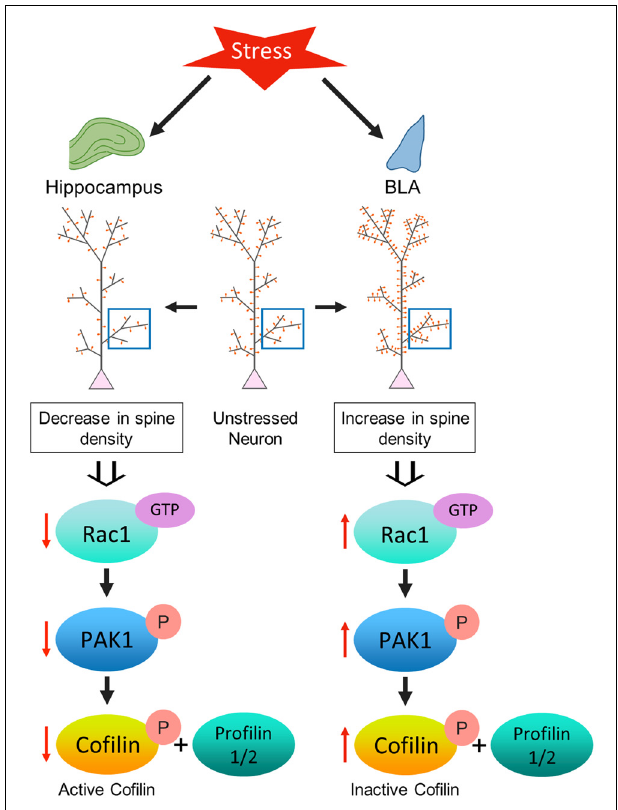
FIGURE 5 | Model depicting the proposed mechanism underlying the contrasting effect of stress-induced structural plasticity in the hippocampus and amygdala. (Left) Schematic representation of the effect of stress on the hippocampus. Chronic stress leads to an aberrant decrease in Rac1 activity in the hippocampus which in turn leads to a decrease in PAK1 phosphorylation. A decrease in PAK1 activity ultimately brings about a decrease in cofilin phosphorylation. An increase in cofilin activity along with a simultaneous decrease in the levels of profilin isoforms may correlate with a decrease in spine density in the hippocampus due to stress. (Right) Schematic representation of the effect of stress on the amygdala. Chronic stress leads to an aberrant increase in Rac1 activity in the amygdala that effectuates an increase in PAK1 phosphorylation. An increase in PAK1 activity causes an increase in cofilin phosphorylation. A decrease in cofilin activity along with a simultaneous increase in the profilin isoforms may be linked with an increase in spine density in the amygdala due to